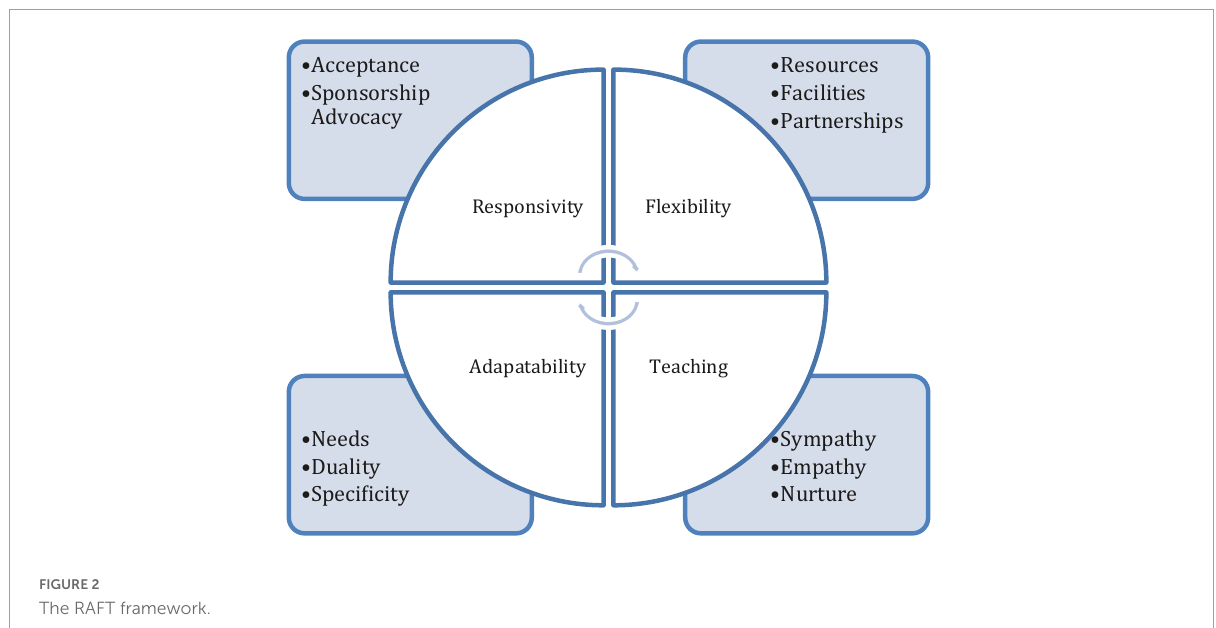
FIGURE2 The RAFT